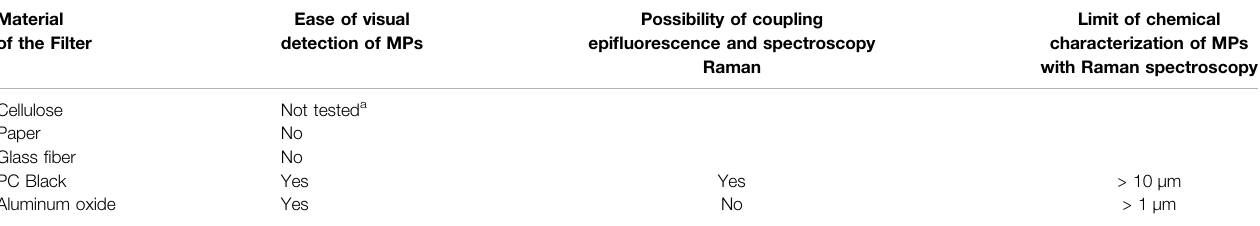
TABLE1| Summarytableofalltested fi lters(exceptforCellulose)andpossibilitiesitoffersforNileRedstainingwithepi fl uorescencemicroscopyandRamanspectroscopyto detect and characterize MPs ingested by copepods from the natural environment. Material Ease of visual of the Filter detection of MPs